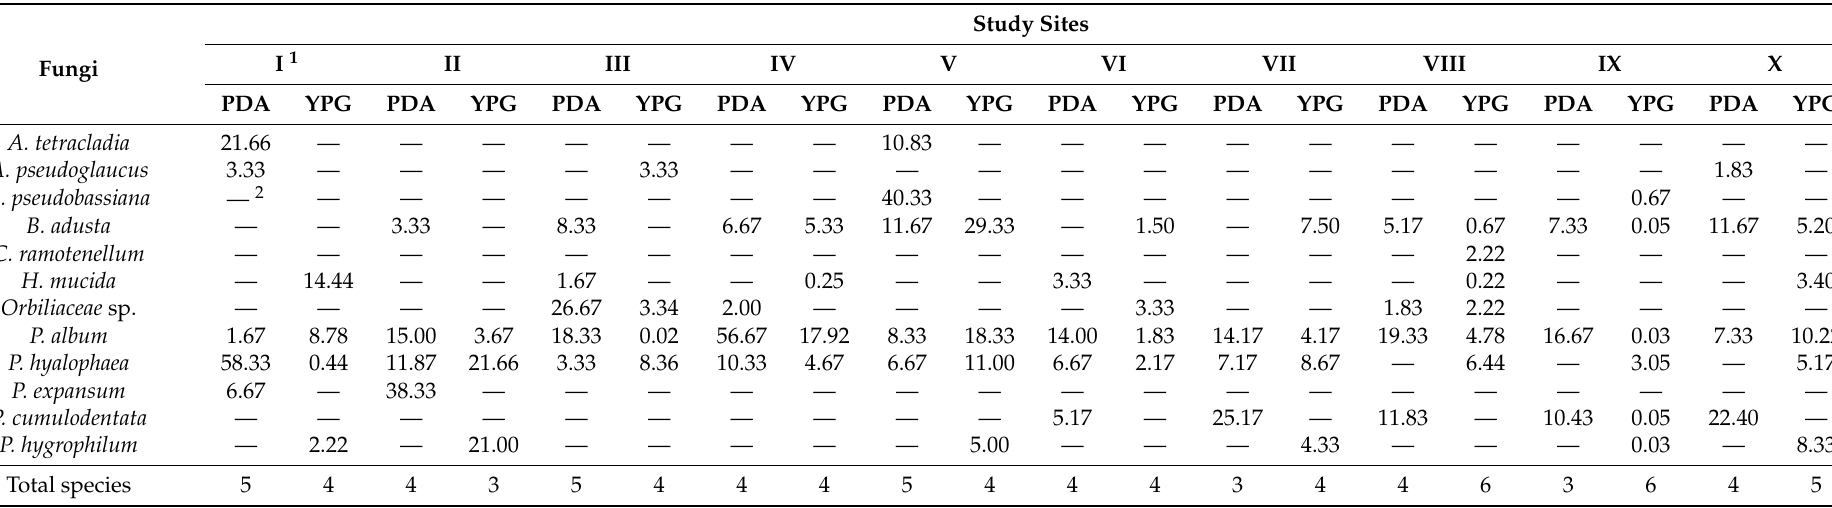
Table A1. Fungi cultured from cryoconite holes (CFU × 10 2 per 1 g) in the Werenskiold Glacier (Spitsbergen) at 7 ◦ C on different media: 1 I–X—study sites; 2 “—” means not